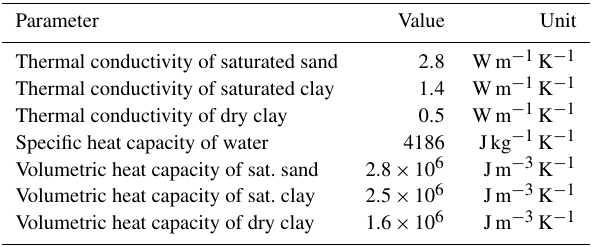
Table 1. Typical values of soil thermal properties. Parameter Value Unit Thermal conductivity of saturated sand 2 . 8 Thermal conductivity of saturated clay Thermal conductivity of dry